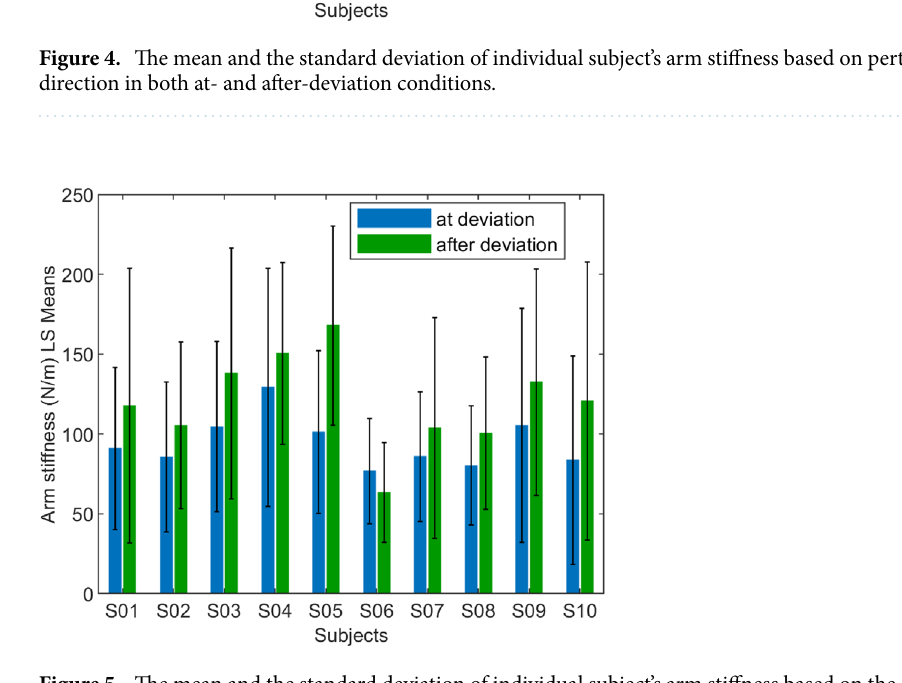
Figure 5. The mean and the standard deviation of individual subject’s arm stiffness based on the condition in both forward and lateral